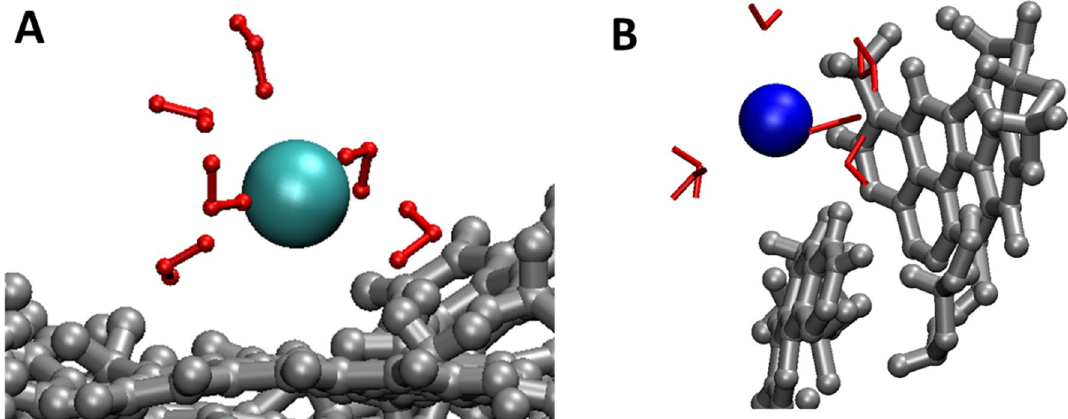
Figure 3. Simulation snapshots demonstrating the inner sphere complexes of Cl − ( A ) and Cs + ( B ) on kerogen IID surface. See Fig. 1 for the color